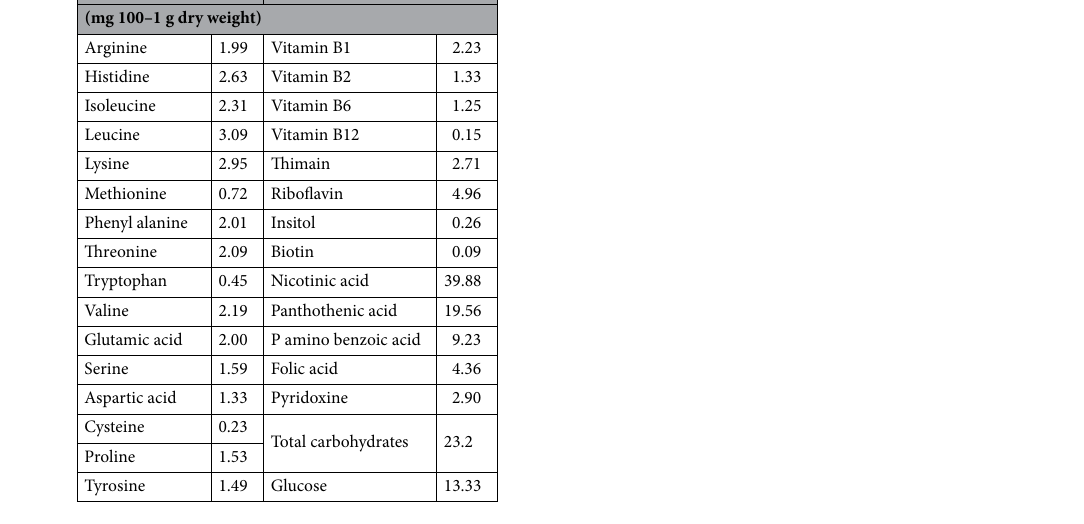
Table 8. Chemical analysis of yeast